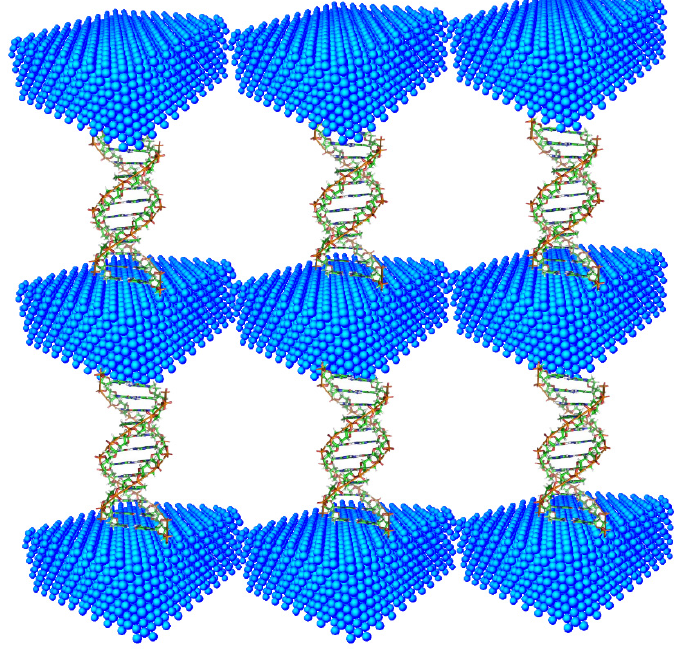
Figure 2. 3D-model of silicon-based nanocomposite .